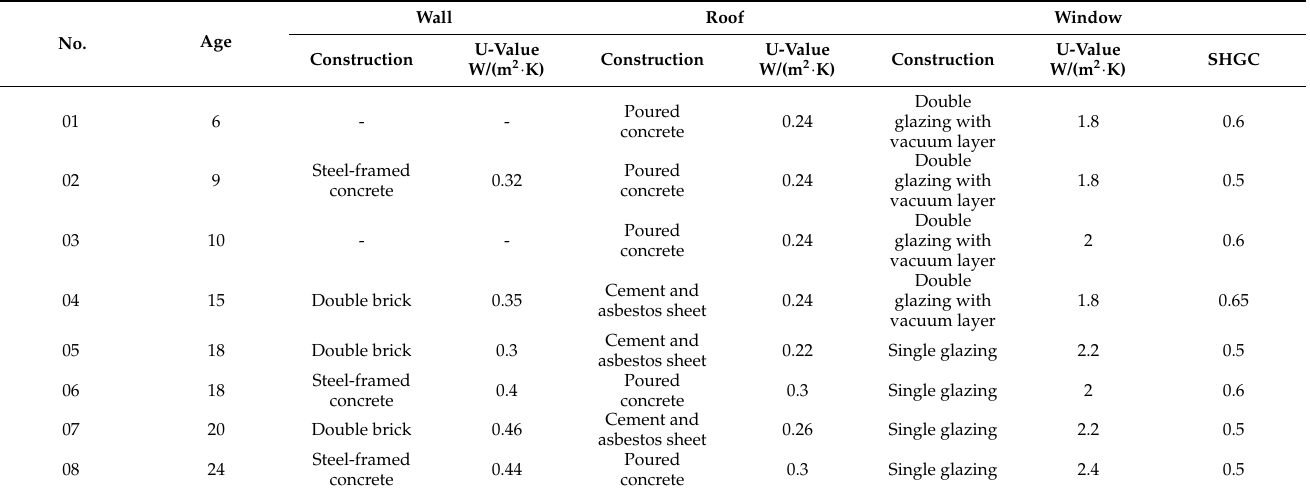
Table 2. Description of the surveyed office